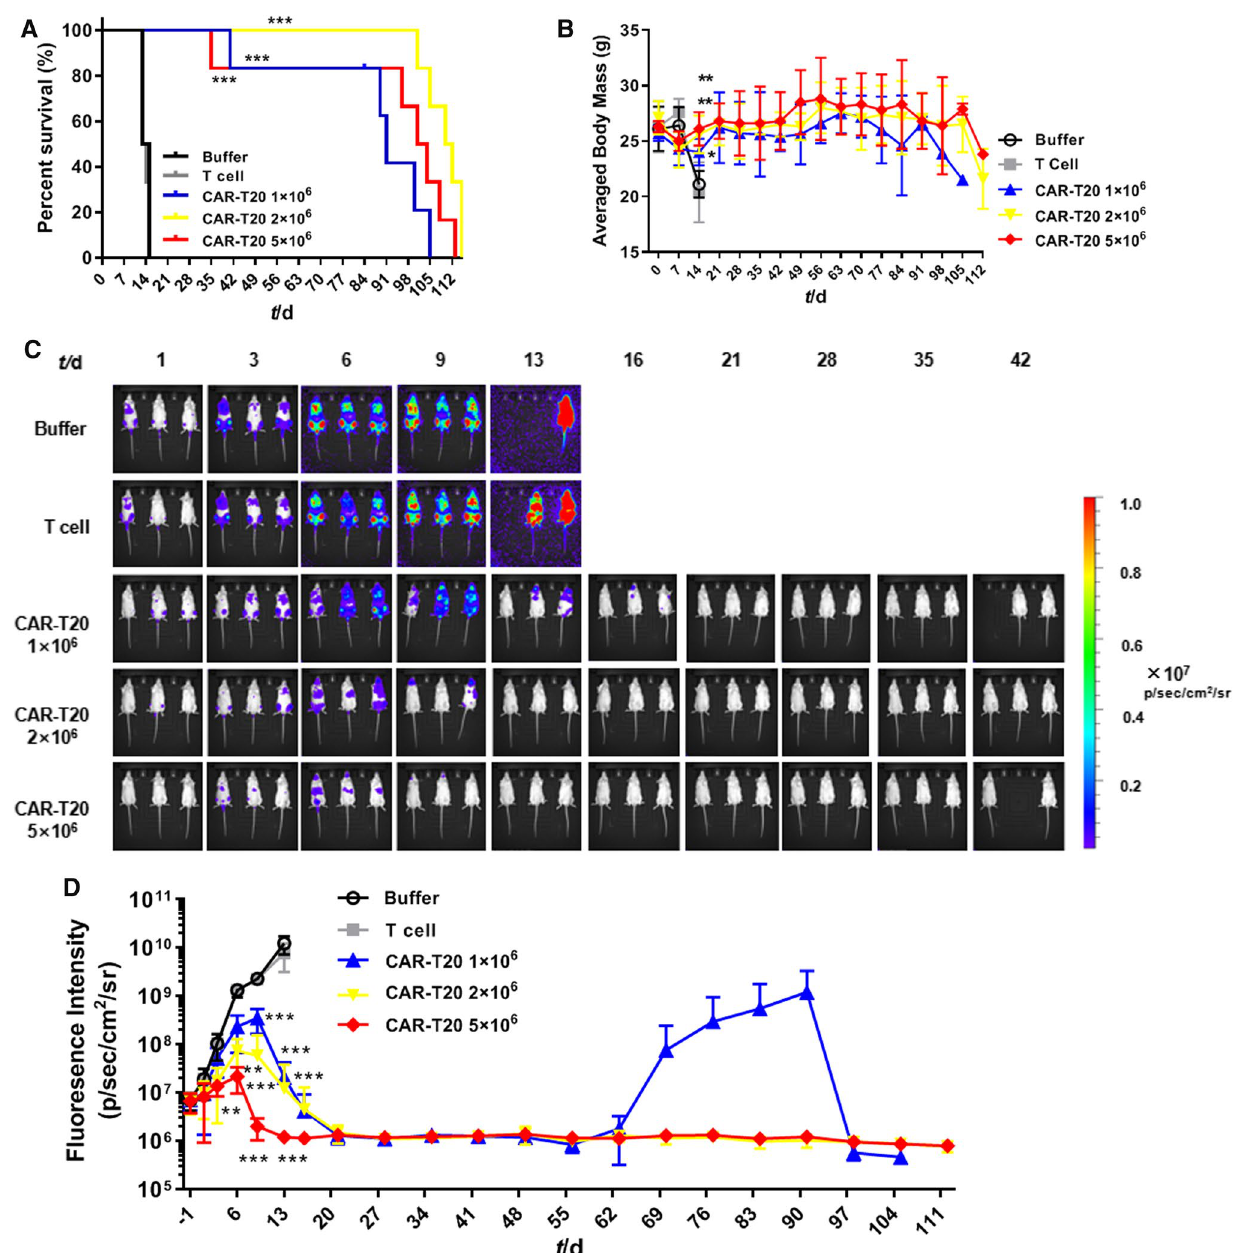
Fig. 3 Effect of CAR-T 20 to the survival rate, body mass and tumor clearance in NSG. The NSG mice bearing Raji-Luc cells were adminis- tered with 1, 2 and 5 × 10 6 CAR-T 20 respectively, and observed for over 16 weeks. A Mean survival rate; B Averaged body mass; C In vivo bioluminescence intensity for Raji-Luc clearance was visualized. D Averaged bioluminescence intensity. The CART-20 could prolong the survival rate, and decreased the overall intensities obviously the since 3 days after administered. Data are shown as the mean ± SD (n = 6). ***p ≤